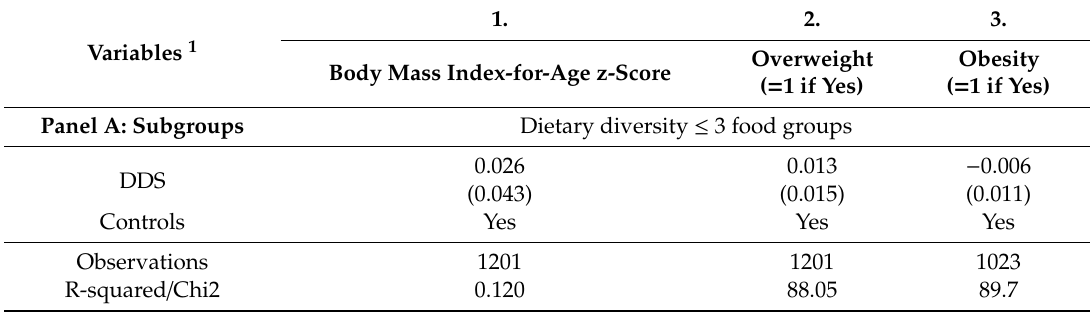
Heterogeneity in the correlation between DDS and nutrition outcomes by dietary diversity